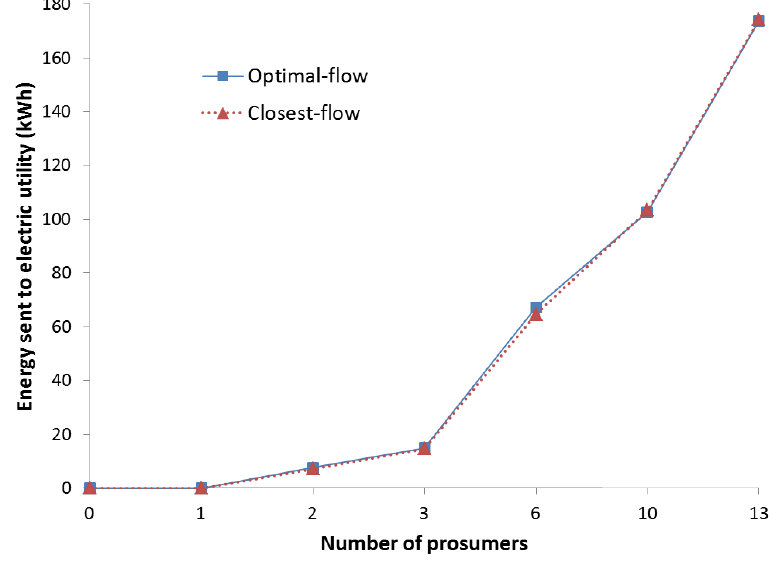
Figure 6. Excess energy sent to the electric utility.